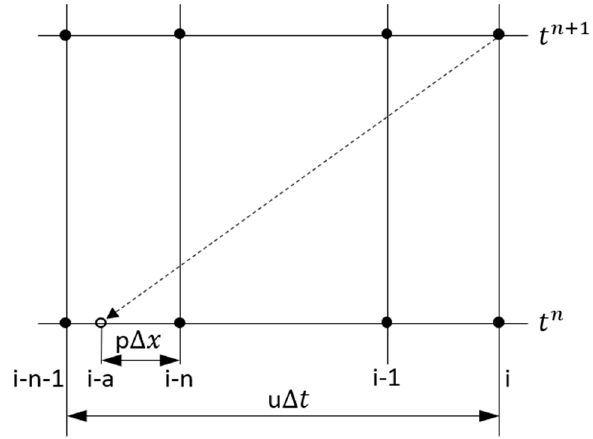
Figure 4. The schematic diagram for the Eulerian grid on the Lagrangian frame, where i is the horizontal grid point; t is the time level; a is the CFL number; n and p are the integer part and the decimal part of a , respectively (i.e., a = n + p , 0 ≤ p < 1 )